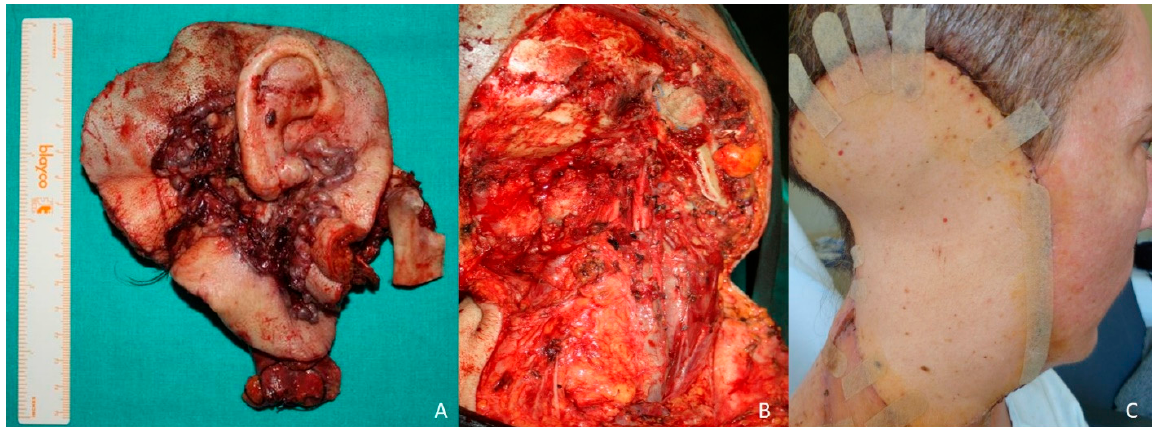
Figure 4. Latissimus Dorsi flap. ( A ) Preauricular basal cell carcinoma with auricular invasion and facial paralysis ( B ). ( C ) Design of the resection.